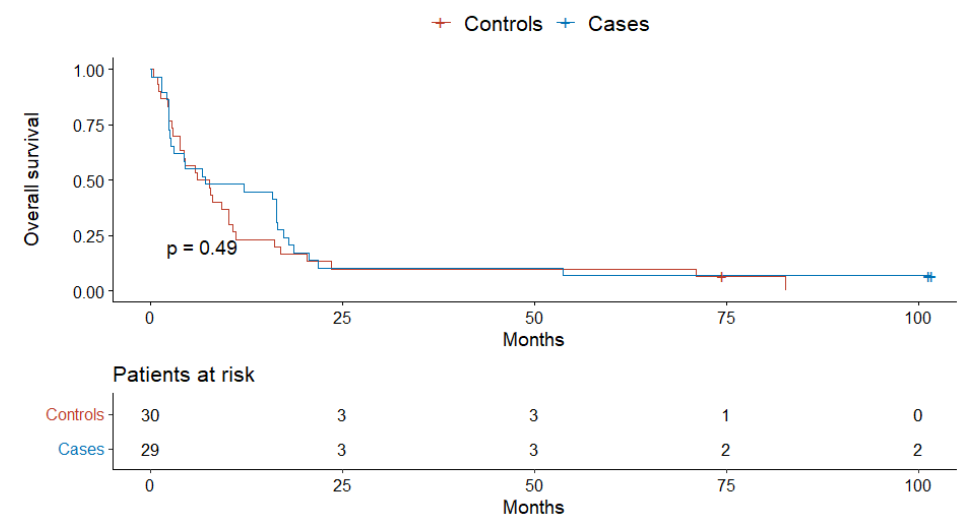
Figure 4. The overall survival of cases and controls with one or two comorbidities.